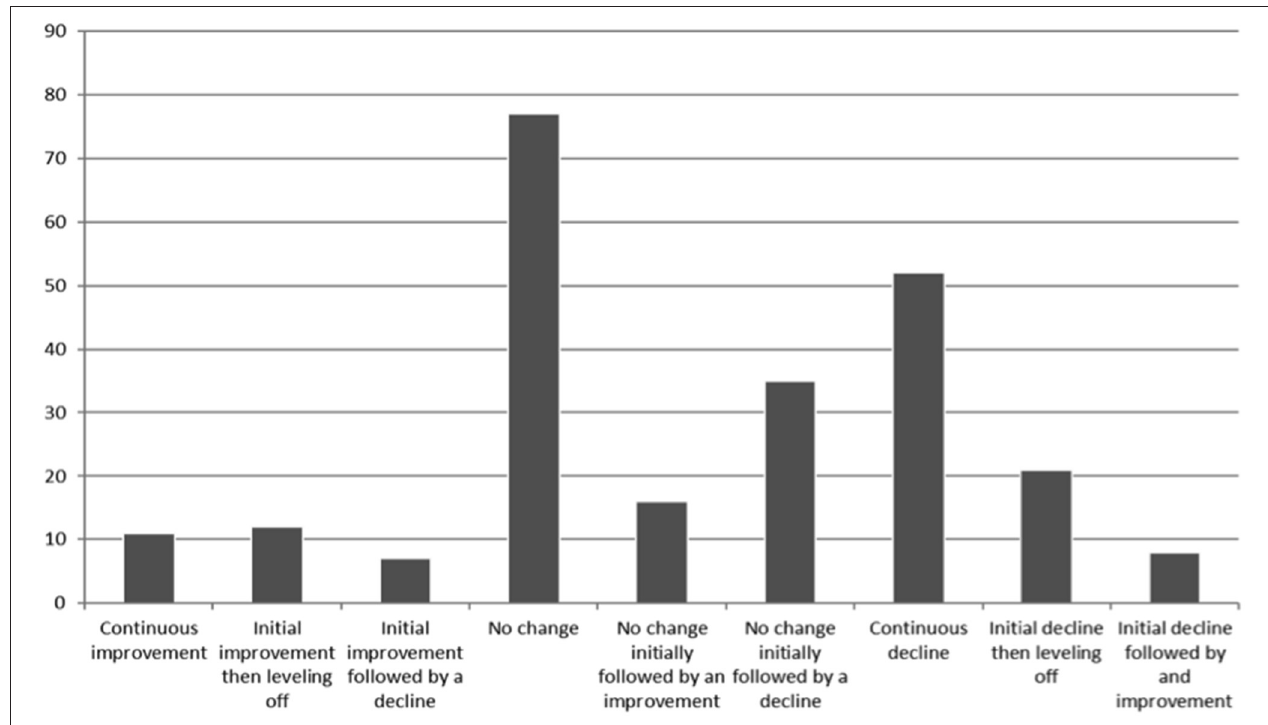
FIGURE 1 | Trajectory of change in physical health.